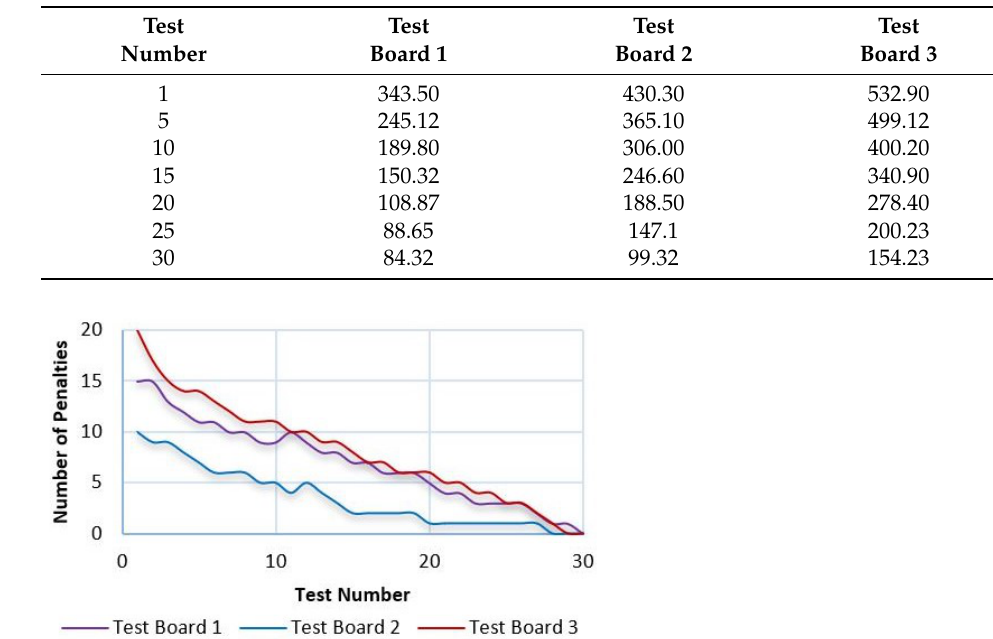
Table 4. Summary of response time in seconds on each test board.